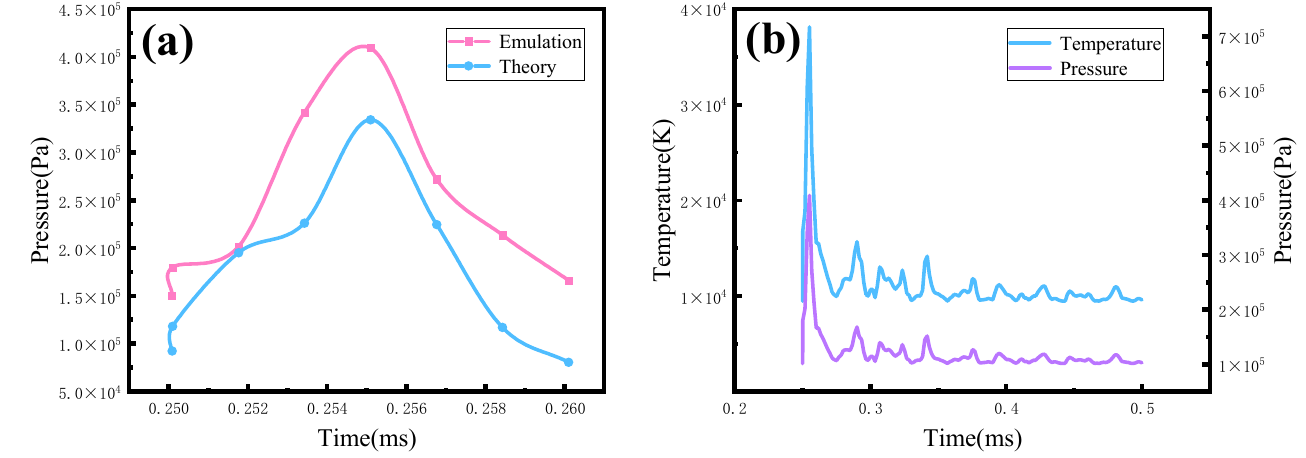
Figure 8. Variation in wavefront pressure and temperature with time: ( a ) variation in wavefront pressure with time; ( b ) variation in wavefront temperature with time.